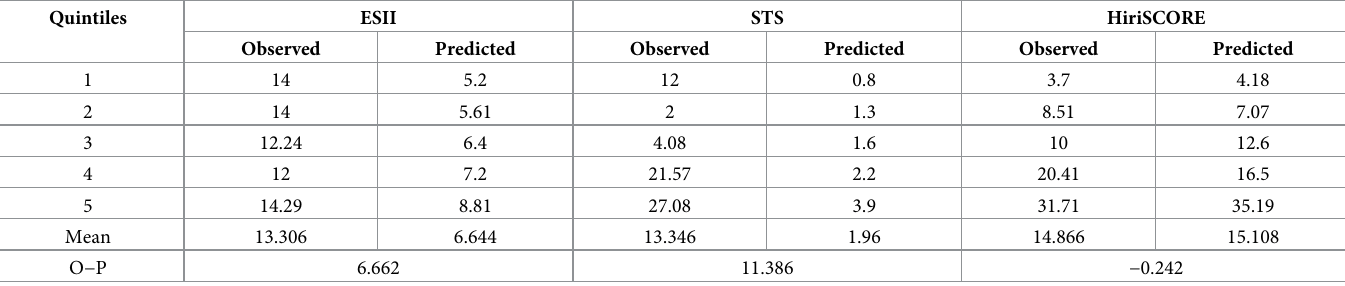
O − P: observed minus